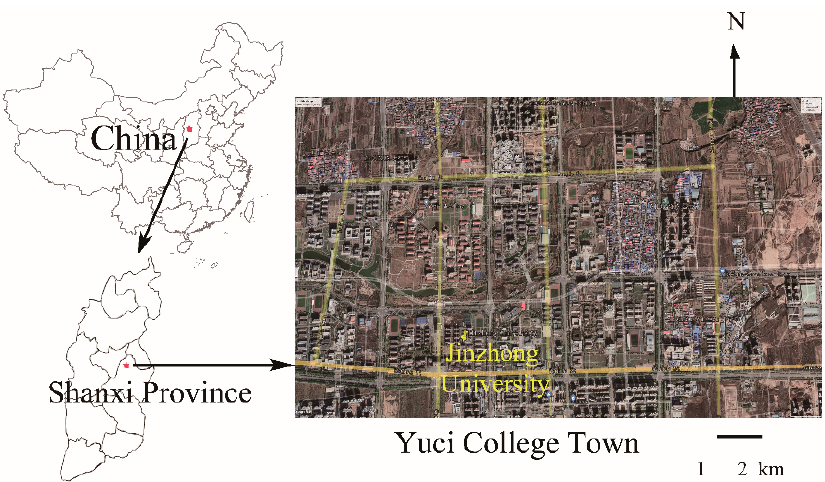
Figure 1. Map of the sampling area in Yuci College Town, Shanxi, China.